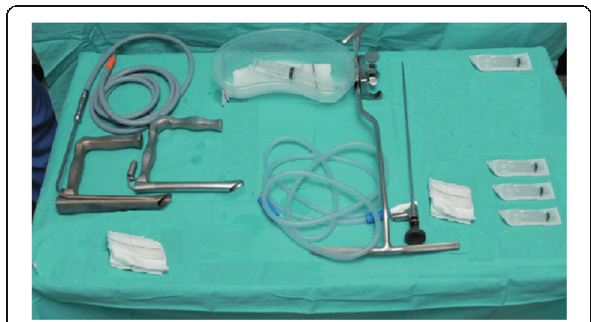
Fig. 2 Laryngoscope and rigid type with instruments used in the